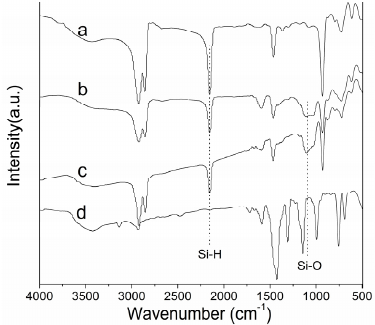
Figure 1. Fourier transform infrared spectra (FT-IR) spectra of ( a ) pure C 18 H 37 SiH 3 products of polymerization of C 18 H 37 SiH 3 catalyzed by using 0.01 g ZIF-8; ( b ) at 30 °C; ( c ) at 90 °C; ( d ) pure ZIF-8.